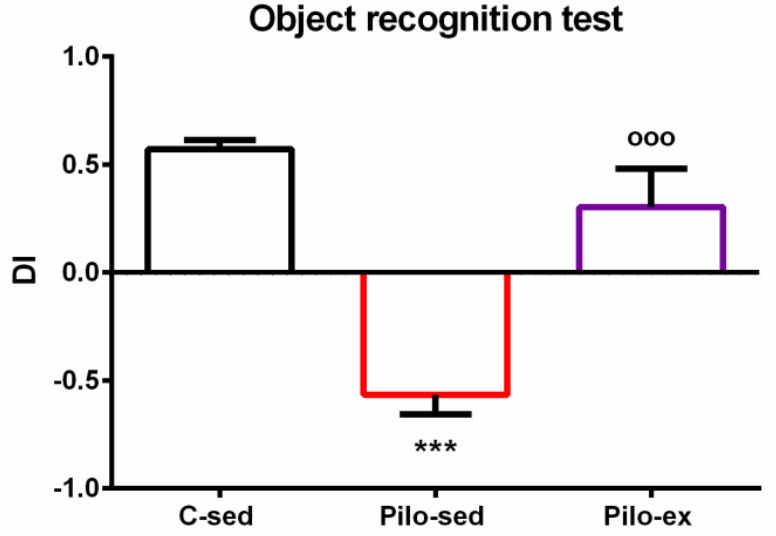
Figure 2. The effect of endurance training, applied before and after SE, on the latency reaction dur- ing the first, second, and re-test days in the step-down test in the pilocarpine-induced post-status epilepticus model of temporal lobe epilepsy. ** p = 0.003, *** p < 0.05 in comparison with the C-sed group; ooo p < 0.001, o p = 0.046 in comparison with the Pilo-sed group. 2.3.2. The Endurance Training, Applied before and after SE, Corrected the Impairment of Associative Memory in the Object Recognition Test in the Pilo-Induced Post-SE Rat Model of TLE ANOVA revealed a main effect of exercise [F(2, 23) = 25.843, p < 0.001] on the dis- crimination index. The post hoc test showed that the Pilo-sed animals had impaired object recognition memory compared to both the C-sed and Pilo-ex groups ( p < 0.001) (Figure 3).